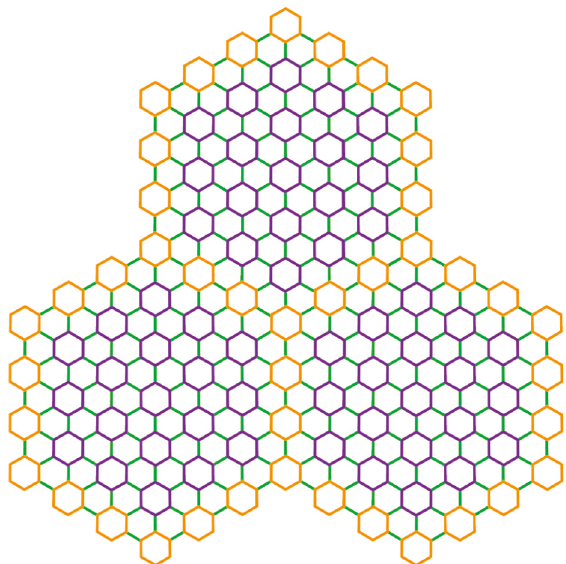
Figure 1: Molecular graph of